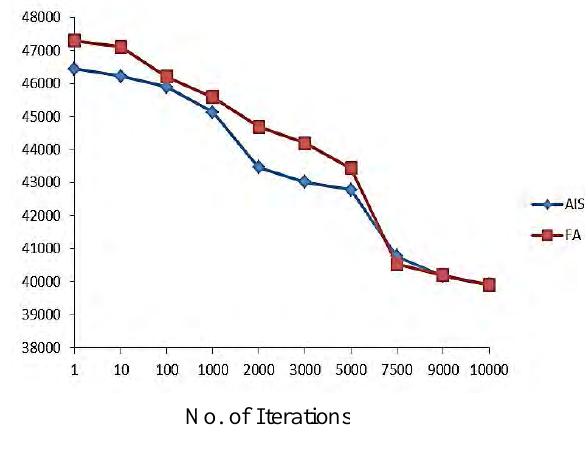
Fig.8 – Convergence graph for 30×10 variable sublot sizes problem (total flow time performance